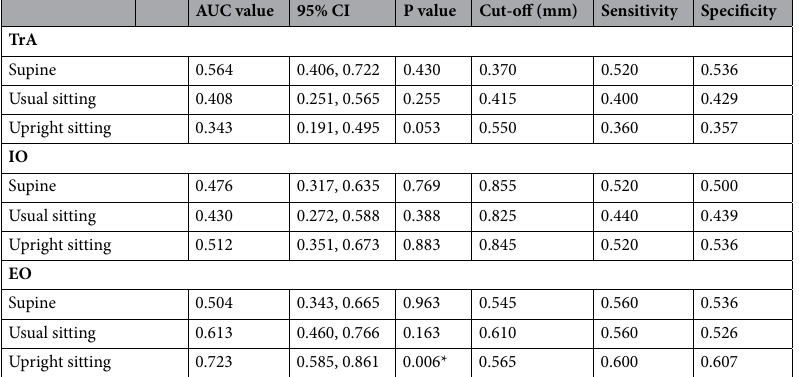
Table 4. ROC analysis of abdominal muscle thickness. AUC area under curve, CI confidence interval, TrA transverse abdominis muscle, IO internal obliqu, EO external oblique. *Means that P value is under